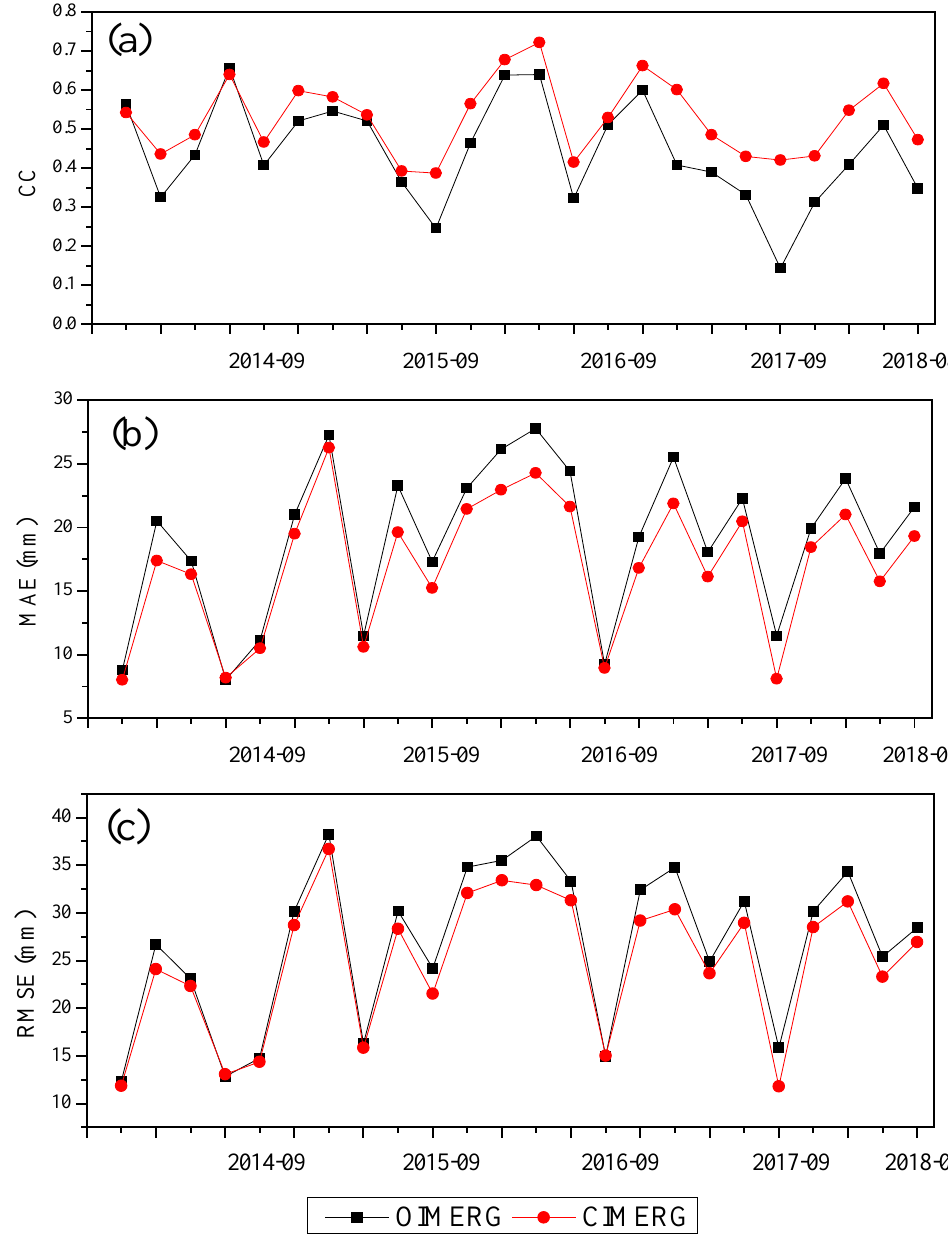
Figure 5. Comparisons of the ( a ) CC, ( b ) mean absolute error (MAE) and ( c ) root-mean-square error (RMSE) before and after OI processing for the warm seasons of 2014–2018.